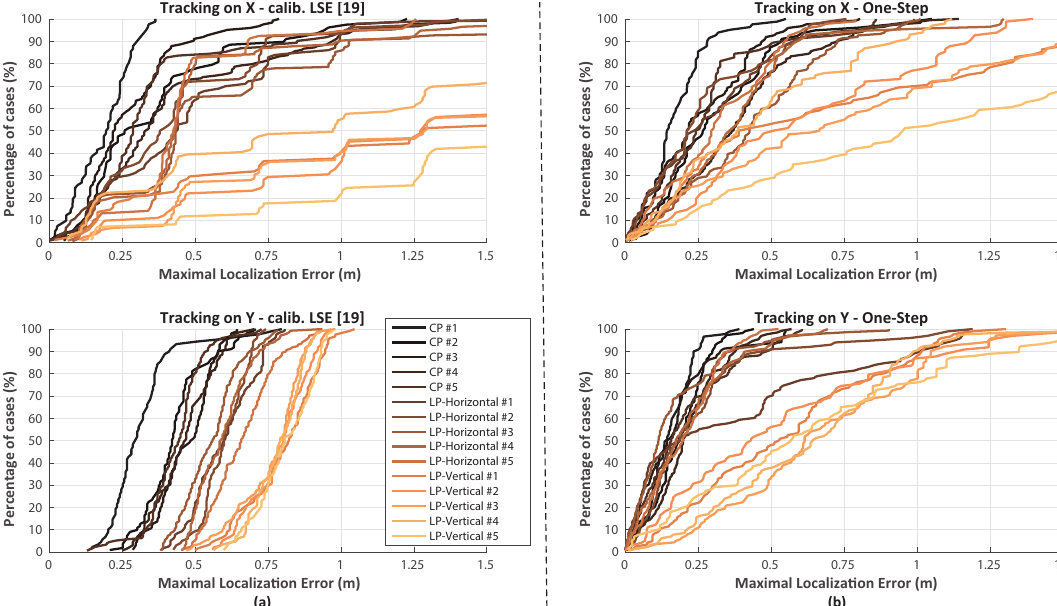
Figure 22. Tracking Error Results CDFs using calibrated LSE [19] ( a ) and uncalibrated One-Step ( b